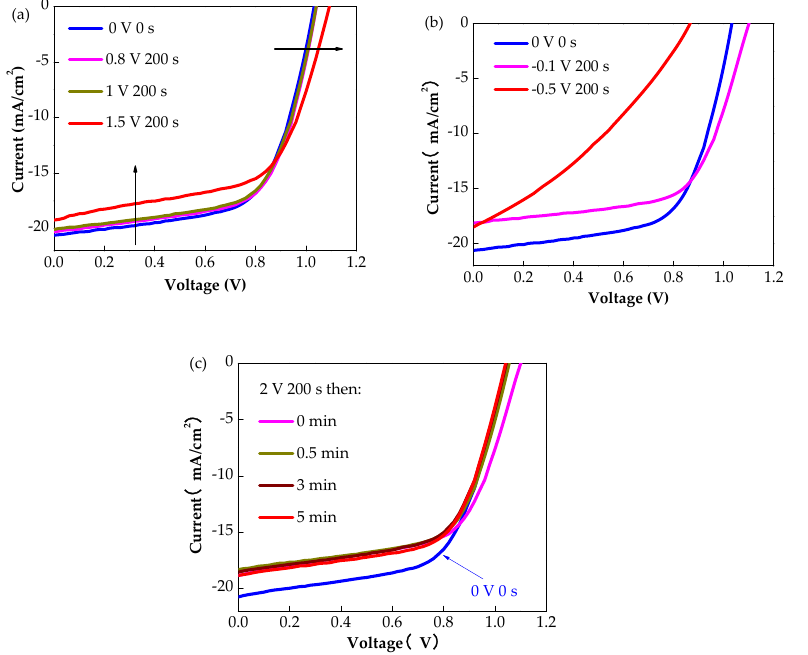
Figure 4. J – V curve of quasi-2D perovskite [(BA) 2 MA 3 Pb 4 I 13 , n = 4] solar cells under external electric field modulation with ( a ) different forward bias at constant time of 200 s. ( b ) Other reversed bias at a continuous time of 200 s. ( c ) Other modulation times at consistent forward bias of 2 V. Table 2. Photovoltaic parameters of electric field ‐ modulated quasi ‐ 2D perovskite solar cells under different modulation times, at a constant forward bias with the same batch of devices.